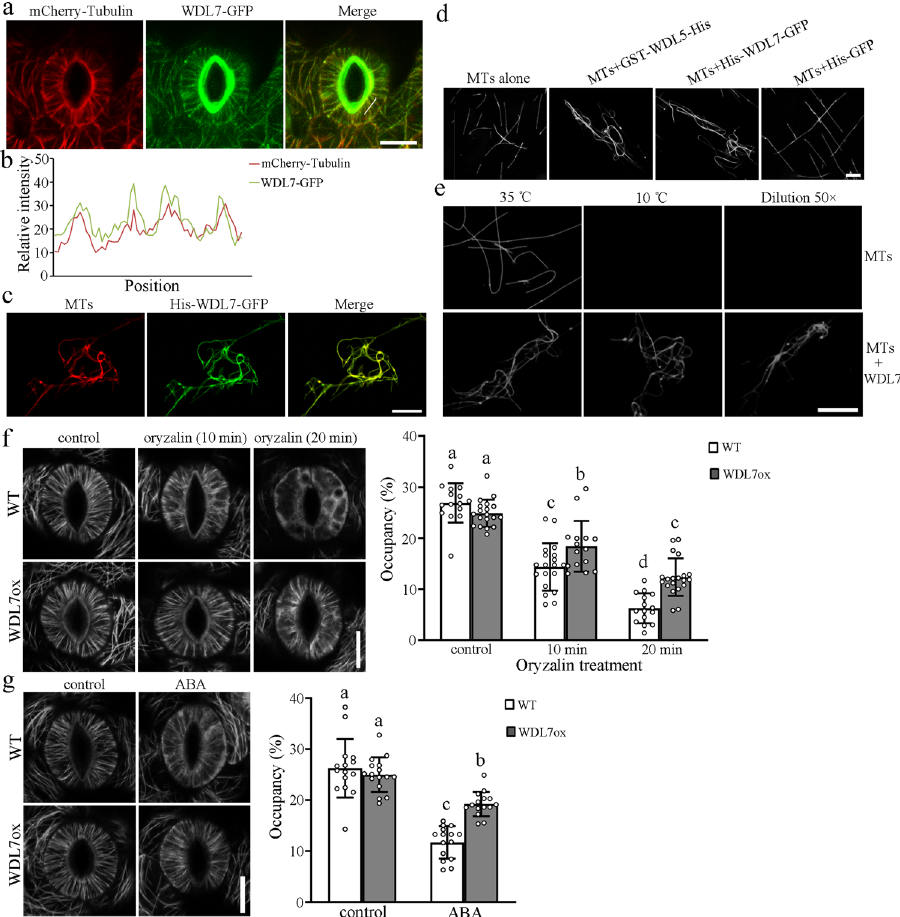
Fig. 4 WDL7 binds to and stabilizes microtubules in vitro and in vivo. a WDL7-GFP colocalizes with cortical microtubules detected in guard cells. Detached rosette leaves of seedlings from WDL7-GFP transgenic plants on an mCherry-tubulin background were incubated in opening buffer for 2 h. The experiment repeated three times with similar results. Scale bar = 10 μ m. b Plot of a line scan drawn in a showing a strong correlation between the spatial localization of WDL7-GFP and cortical microtubules. c His-WDL7-GFP colocalizes with microtubules polymerized from rhodamine-labeled tubulin in vitro. The experiment repeated three times with similar results. Scale bar = 10 μ m. d WDL7 induced the formation of microtubule bundles in vitro. Images show microtubules polymerized from rhodamine-labeled tubulin incubated with 3 μ M His-WDL7-GFP, GST-WDL5-His, or His-GFP protein for 30 min. The experiment repeated three times with similar results. Scale bar = 5 μ m. e WDL7 stabilizes microtubules against cold and dilution-induced depolymerization. The experiment repeated three times with similar results. Scale bar = 10 μ m. f Cortical microtubules in guard cells from WT and WDL7- GFP transgenic seedlings (WDL7ox) on an mCherry-tubulin background treated with 5 μ M oryzalin for 10 and 20 min. Scale bar = 10 μ m. The graph shows the densities of microtubules in f . Data represent mean ± standard deviation (SD) values from three independent experiments with a minimum of 15 cells each. g Cortical microtubules in guard cells from WT and WDL7-GFP transgenic seedlings (WDL7ox) on an mCherry-tubulin background treated with 0 and 10 μ M ABA for 40 min. Scale bar = 10 μ m. The graph shows the densities of microtubules in g . Data represent mean ± standard deviation (SD) values for three independent experiments with a minimum of 15 cells each. Different letters represent signi fi cant differences at p < 0.01 (one-way